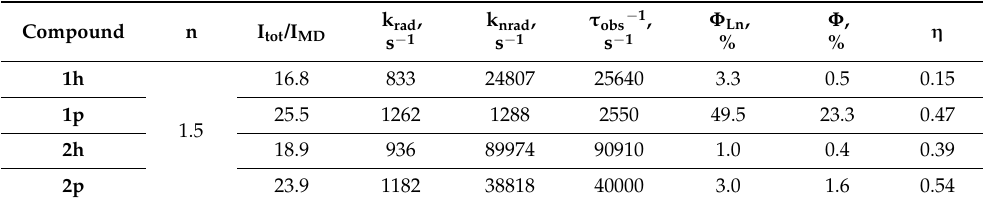
Table 4. Photophysical parameters for complexes in solid state. Internal quantum yields Φ Ln and sensitization coefficients η